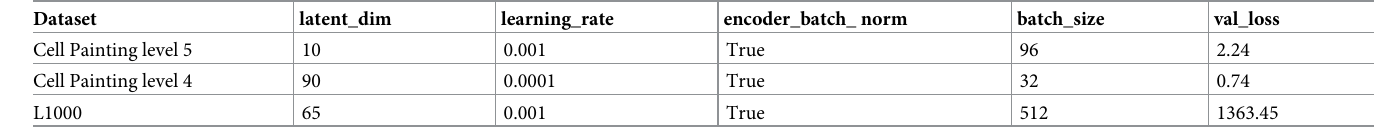
Table 2. Hyperparameter combination of the top performing models for each